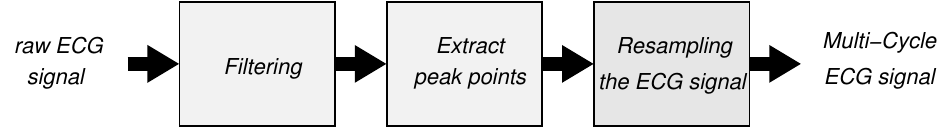
Figure 1. Multi-stage process for acquiring a standard frame of multi-cycle ECG